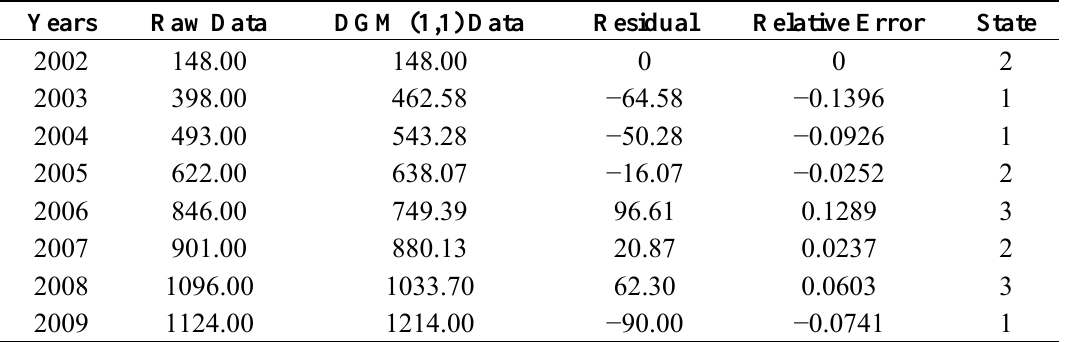
Table 5. Categorizing China’s yearly biofuel production data into states according to the DGM (1,1) model (2002 to 2009).